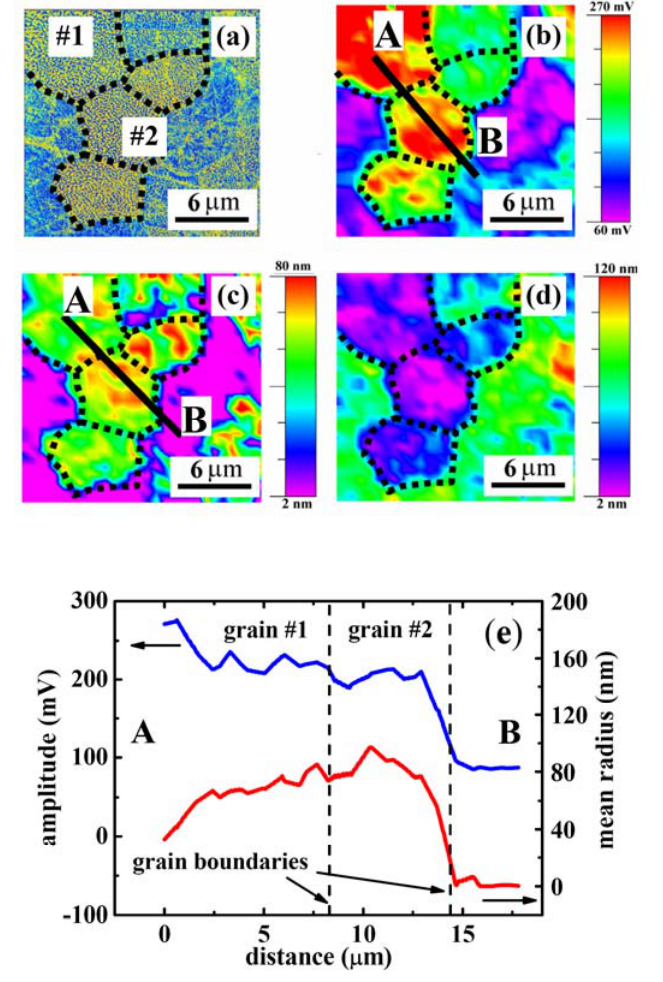
Figure 6. Original phase image ( a ) of the contrast grain, maps of the amplitude ( b ); the radius ( c ) and the width ( d ) after FFT procedure; ( e ) variation of the piezoresponse (blue line) and radius (red line) across of two neighboring grains (for b , c